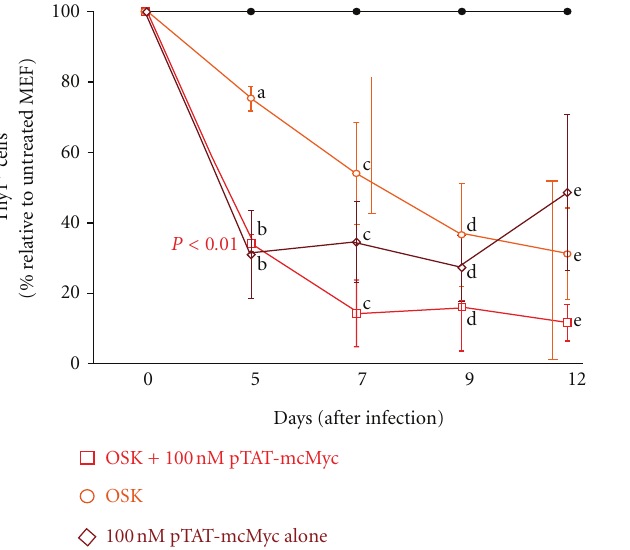
Figure 4: Thy1 downregulation by OSK, pTAT-mcMyc alone or OSK+pTAT-mcMyc at 5, 7, 9, and 12 days after infection. MEFs were infected with retrovirus harboring transgenes for mOct4, mSox2, and mKlf4 (OSK; orange line). 100 nM pTAT-mcMyc recombinant protein was applied to OSK expressing cells (red line), or to non-transduced MEFs (brown line). On days 5, 7, 9, and 12 after infection, percentage of cells expressing the fibroblast marker Thy1 was assessed in all treatment groups by flow cytometry with results normalized to untreated MEF controls (black line). Mean ± SEM of n = 2 experiments shown.